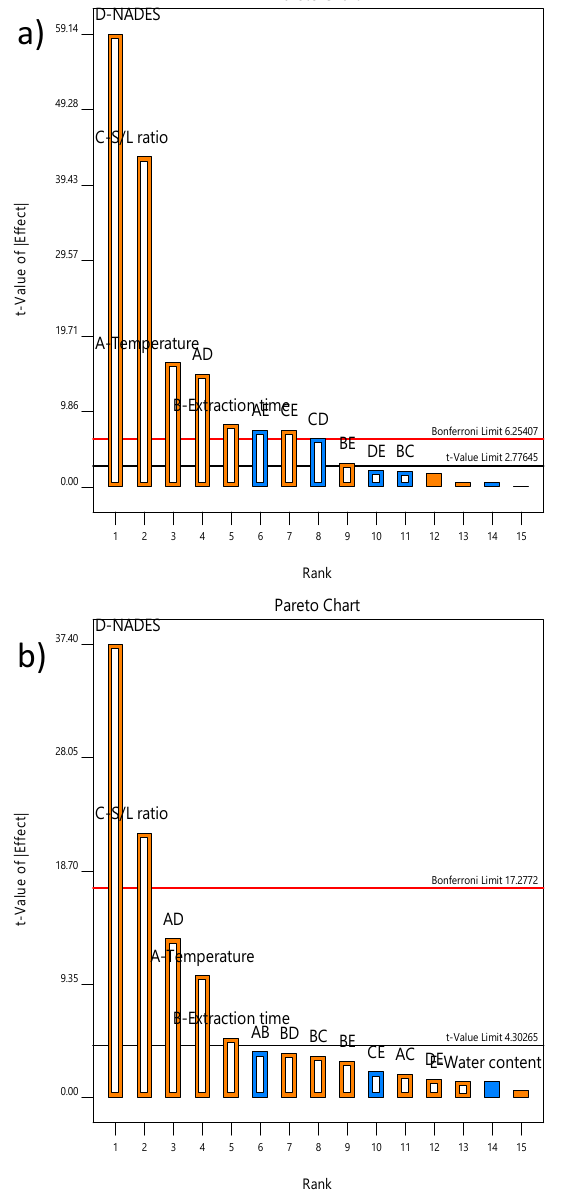
Figure 2. Pareto chart exhibiting effects of temperature (A), extraction time (B), L/S ratio (C), NADES (D) and water content (E) on ( a ) TP and ( b ) DPPH.